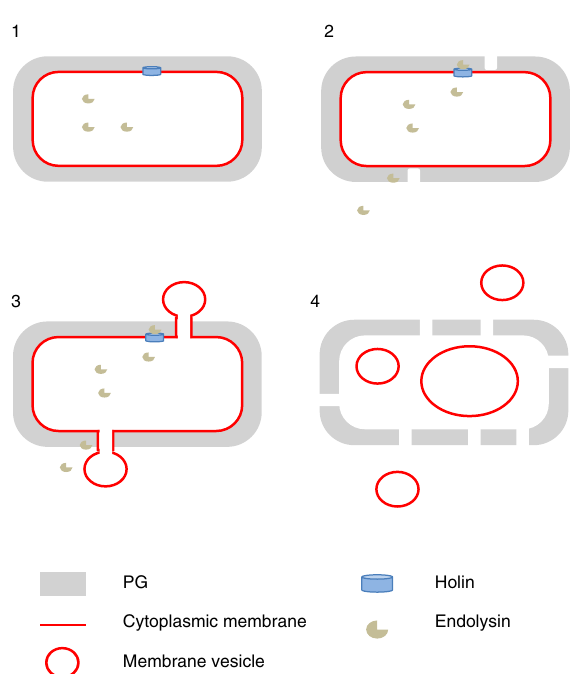
Fig. 5 Schematic model of MV production by the holin – endolysin pathway in B. subtilis . Step 1, the holin forms pores in the cytoplasmic membrane to allow the endolysin to access the PG. Step 2, the endolysin degrades the PG and creates holes. The PG can also be degraded from outside, e.g., by endolysins released from neighboring cells. Step 3, the cytoplasmic membrane is extruded through the holes in the PG, presumably due to high cell turgor. Step 4, the MVs are released. We also observed that intracellular membrane fragments can vesicularize and may eventually be released from the dying